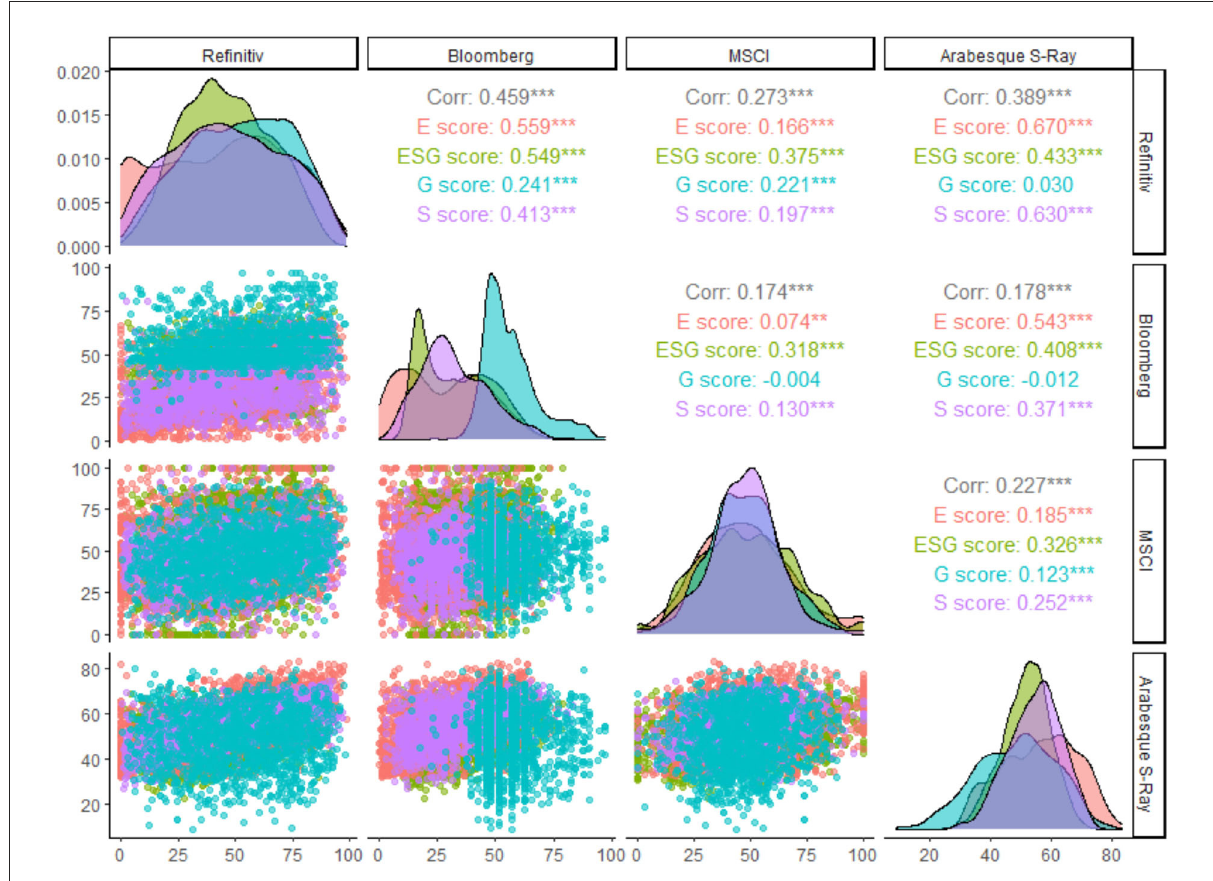
FIGURE8 Correlation between ESG scores across different databases. This figure is based on the four databases in